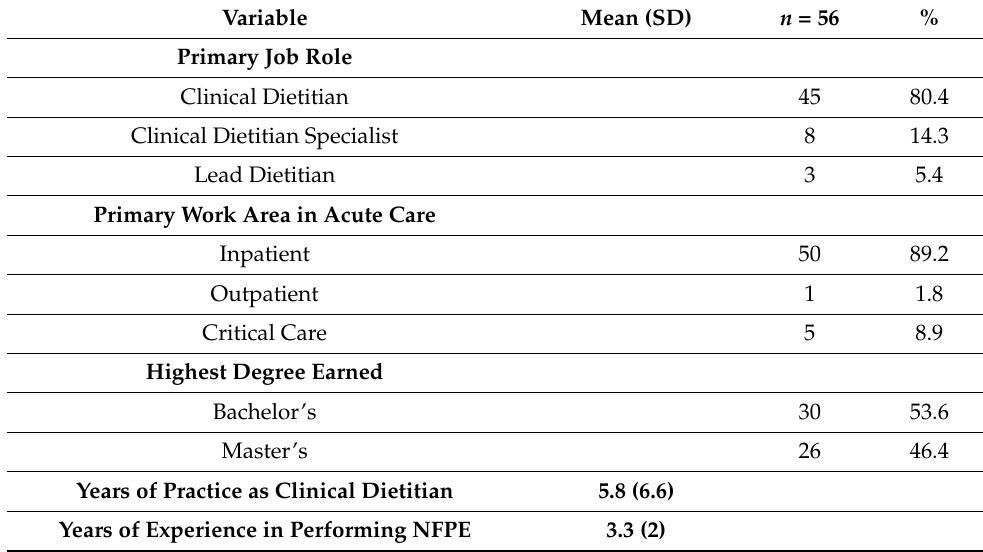
Table 1. Demographic Characteristics of RDN